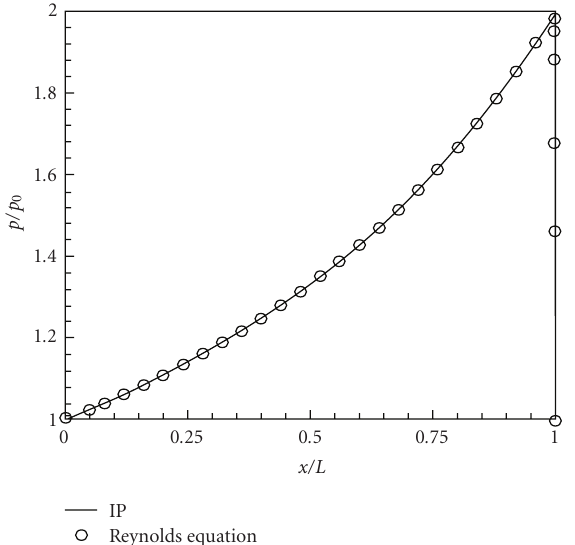
Figure 6: The pressure distribution of the slider bearing for L = 1mm and σ = 1, cited from [36].